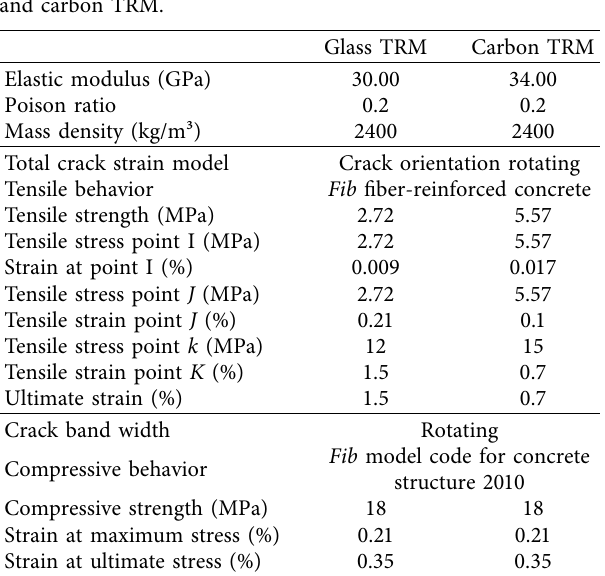
Table 3: Material properties of total strain crack model for glass and carbon